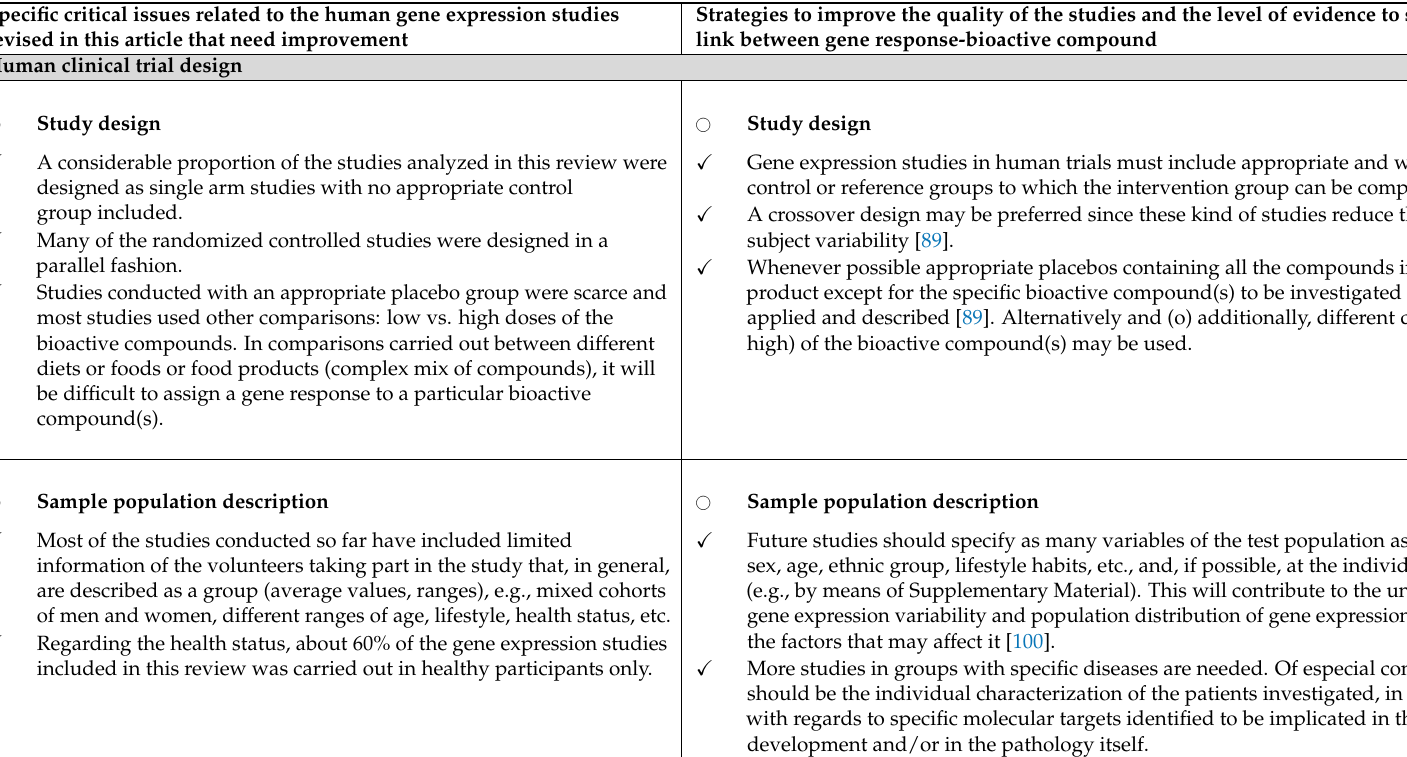
Table 5. General recommendations to further enhance the quality and relevance of future intervention trials looking at the effects on gene expression of dietary bioactive compounds in